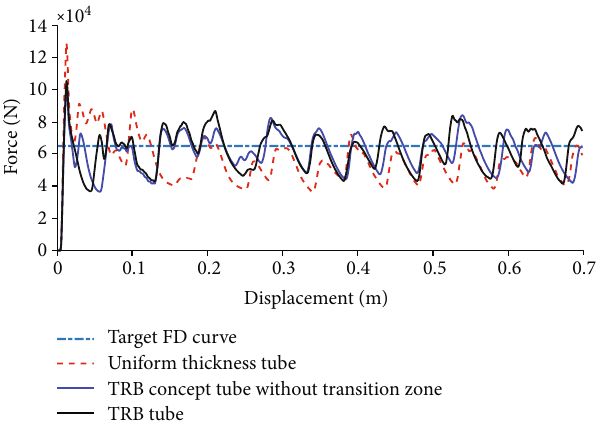
Figure 17: The FD curve of the uniform thickness tube and designed tube.